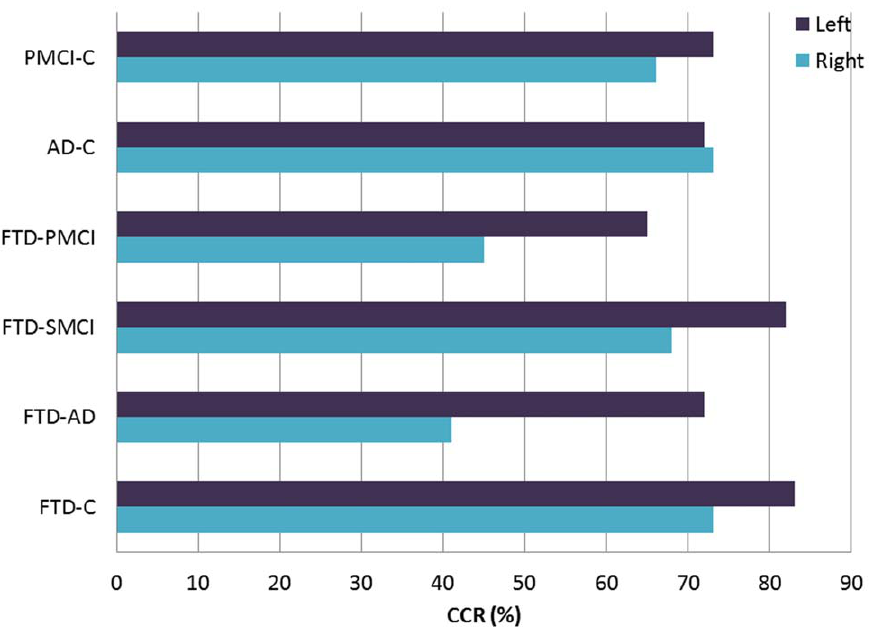
Figure 3. Accuracies (%) of hippocampal volumetry in the following comparisons C vs. PMCI, C vs. AD, PMCI vs. FTD, SMCI vs. FTD, AD vs. FTD and C vs. FTD.